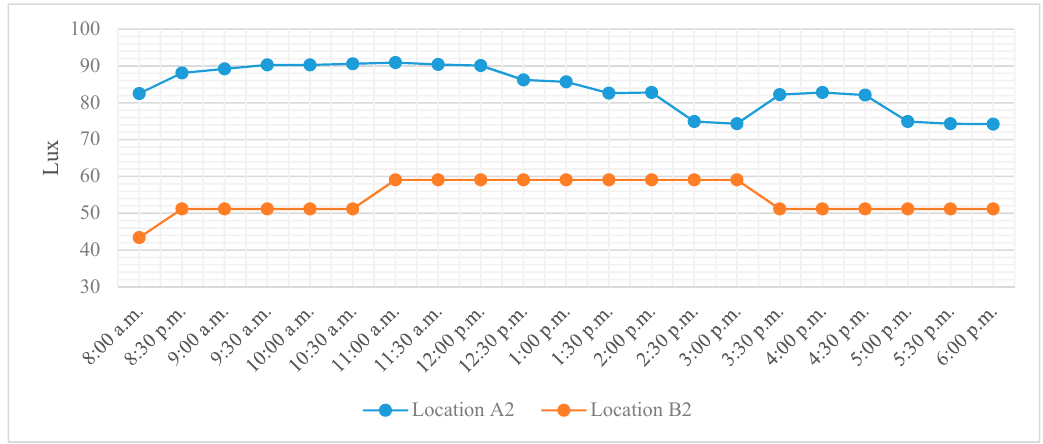
Figure 17. Indoor light intensity in the room of Building A (Location A2) and Building B (Location B2).